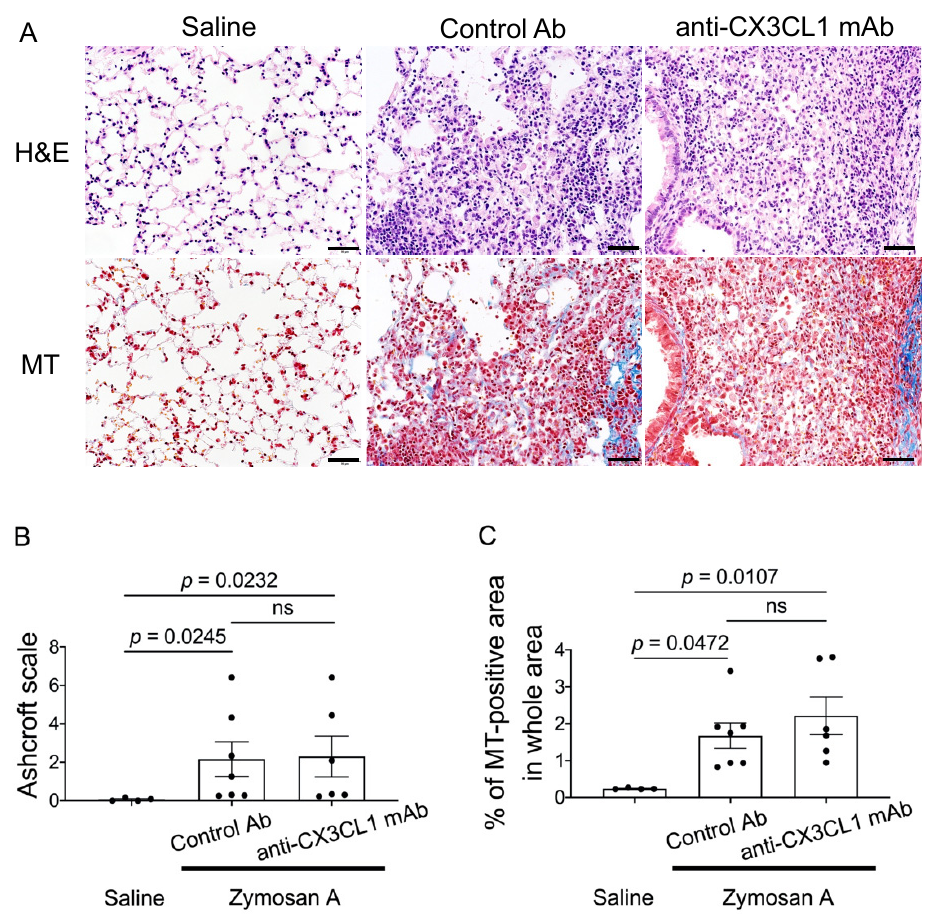
Figure 3. No significant changes in lung fibrosis by the anti-CX3CL1 mAb treatment in SKG-ILD. SKG mice were treated with an intraperitoneal injection of control Ab (hamster immunoglobulin) ( n = 7) or anti-CX3CL1 mAb ( n = 6) twice a week for 12 weeks immediately after the administration of zymosan A until euthanization. ( A ) Representative images of lung tissues stained with H&E (upper panels) or MT (lower panels). Original magnification × 200. Scale bars indicate 50 µ m. ( B ) The Ashcroft scale was used to assess H&E-stained lung tissues. ( C ) The percentage of MT-positive (blue color-stained) areas in the whole area. The black points indicate each sample value. Data are expressed as means ± standard error of the mean (SEM). ns, not significant. The Kruskal–Wallis test was used with Dunn’s test as a post hoc test.